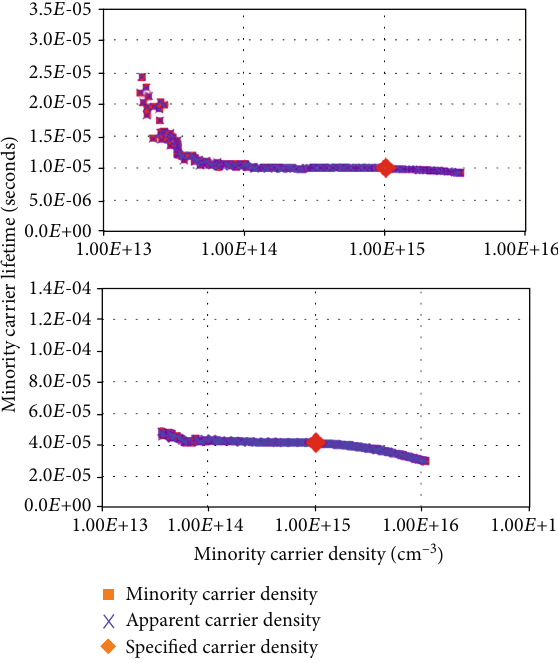
Figure 8: Minority carrier lifetime versus minority carrier density for the ozone-treated bare wafer (top) and the ozone-treated commercial blue wafer (bottom) both annealed at 600 ° C for 90 seconds. The speci fi ed carrier density is 10 15 cm -3